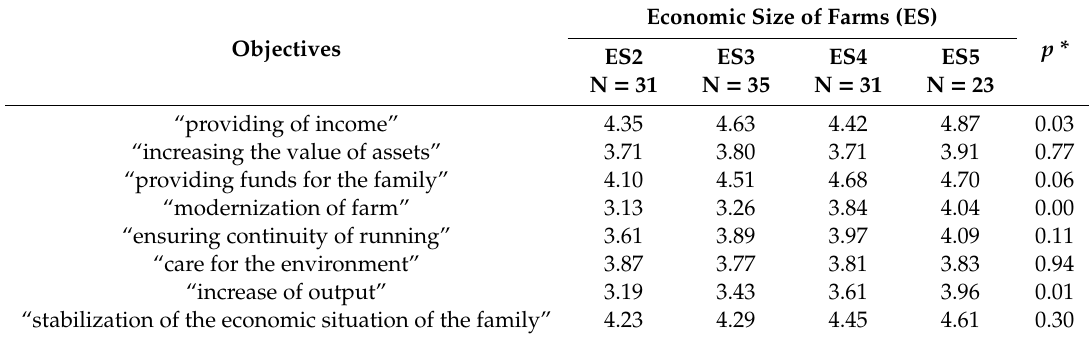
Table 3. The validity of the objectives of operation in the examined agricultural holdings in the Wielkopolska region due to the economic size of